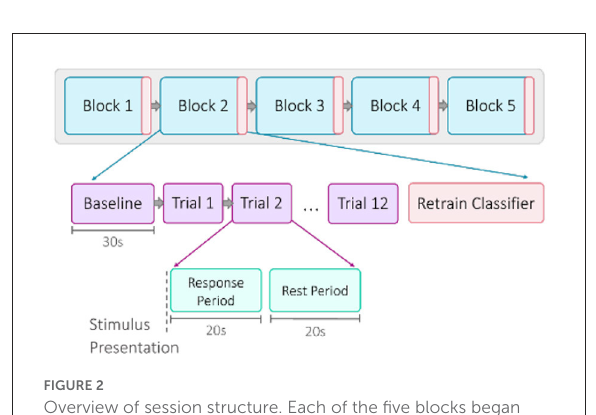
FIGURE2 Overview of session structure. Each of the five blocks began with a 30-s baseline recording, followed by 12 trials. A trial was composed of a 20-s response period of stimulus presentation and a 20-s rest period. For the online sessions, the classifier was retrained after each